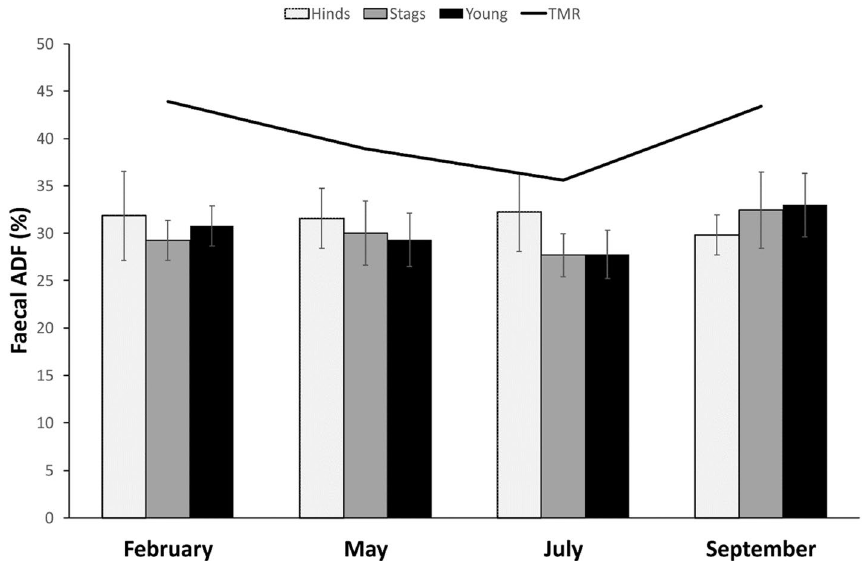
Figure 3. Faecal ADF content for red deer hinds, stags, and young along the 4 studied periods (seasons). The line indicates the percentage of ADF found in the feedstuff ( TMR total mixed ration) that animals were provided during the study.